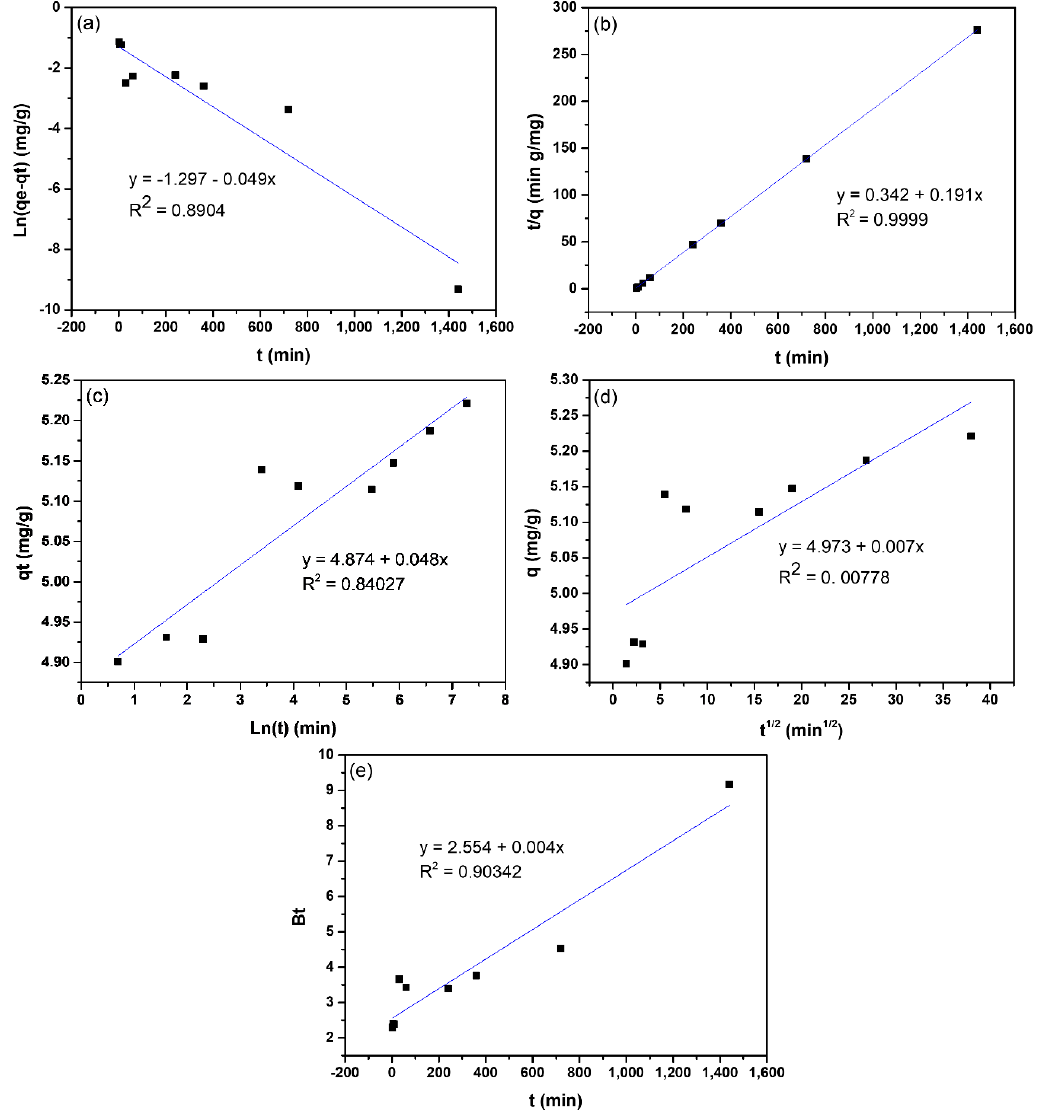
Figure 8. Fittings for 2AgSBA-15: ( a ) pseudo-first-order, ( b ) pseudo-second-order, ( c ) Elovich, ( d ) intraparticle diffusion, and ( e ) Boyd models.